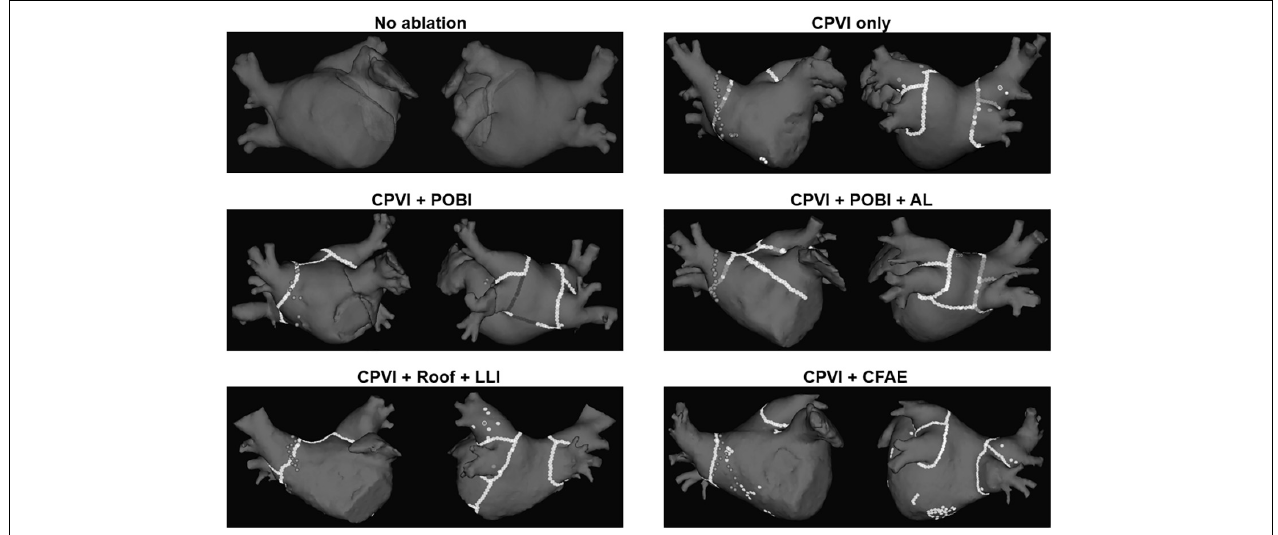
FIGURE 2 | Five different protocols of virtual ablation. AL, left atrial anterior linear line; CFAE, complex fragmented atrial electrogram; CPVI, circumferential pulmonary vein isolation; LLI, left atrial left lateral isthmus line; POBI, posterior box isolation; Roof, left atrial roof